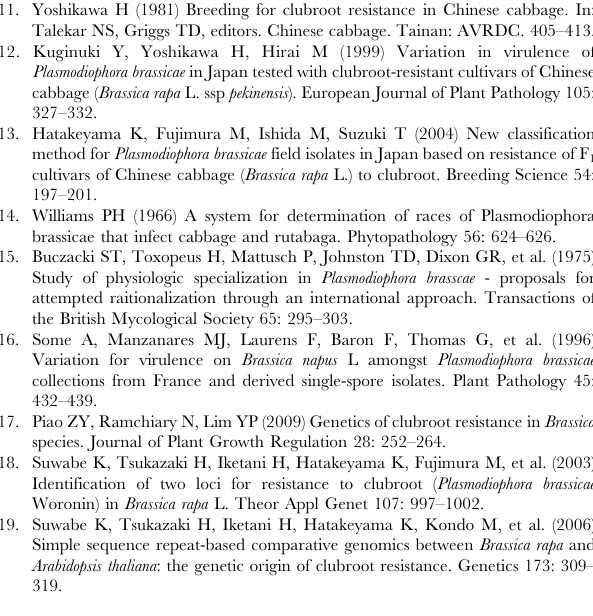
Figure S1 Resistance responses of transgenic Col-0 lines carrying Crr1 promoter: Crr1G004 cDNA construct (Cp_01–19) or wild-type Col-0 plants, to Ano-01. The mean ( ± SD) is based on the average of 3 clubroot tests. Figure S2 Resistance of transgenic Col-0 plants with Crr1 G004 to different pathotypes. Col-0 and 2 T 3 lines were inoculated with a representative isolate of each pathotype: No. 5 (group 1), No. 7 (group 2), No. 14 (group 3), and No. 9 (group 4). The mean ( 6 SD) is based on the average of 3 tests. Figure S3 Schematic representation of Crr1a allelic structure in resistant G004 and susceptible A9709. Black